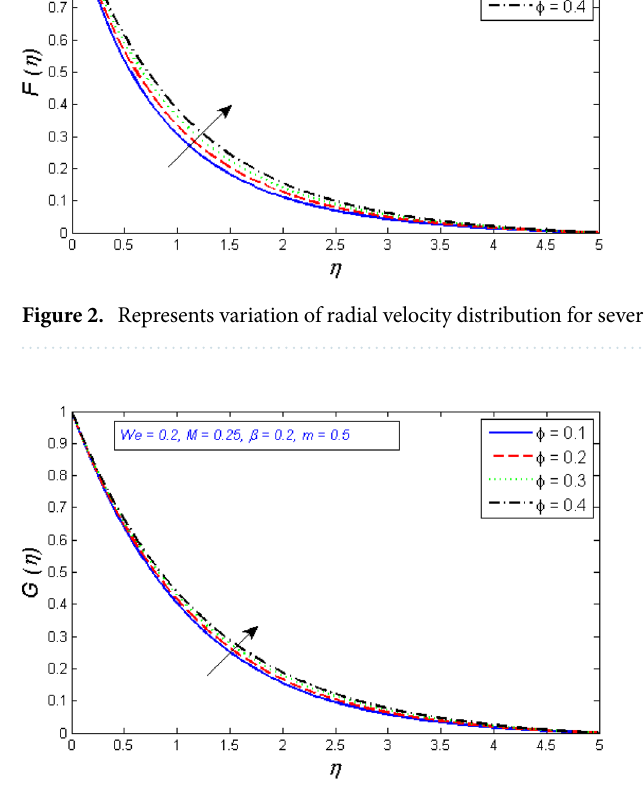
Figure 3. Represents variation of tangential velocity distribution for several number of volume fraction φ .